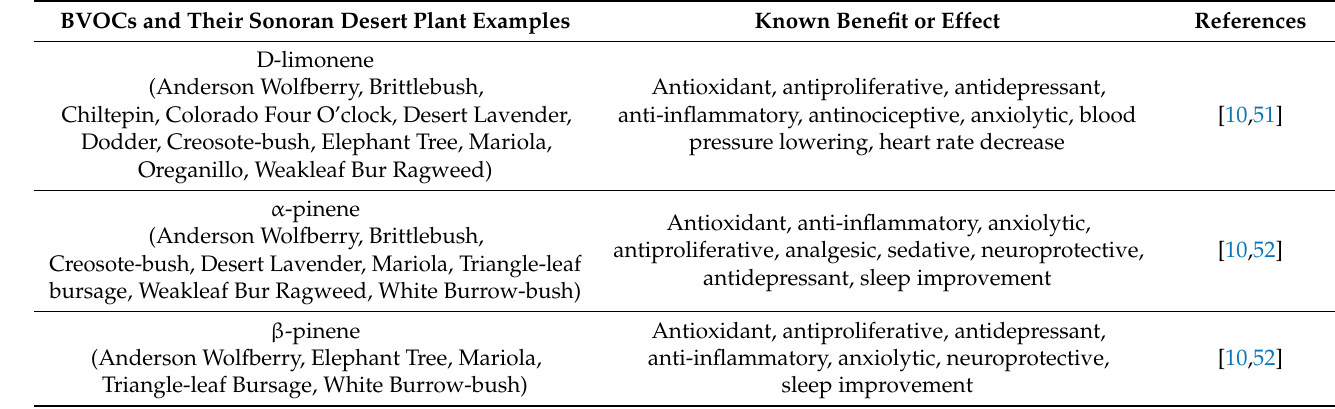
Table 4. Known Health Benefits of Volatiles Recorded in Sonoran Desert Nurse Plant